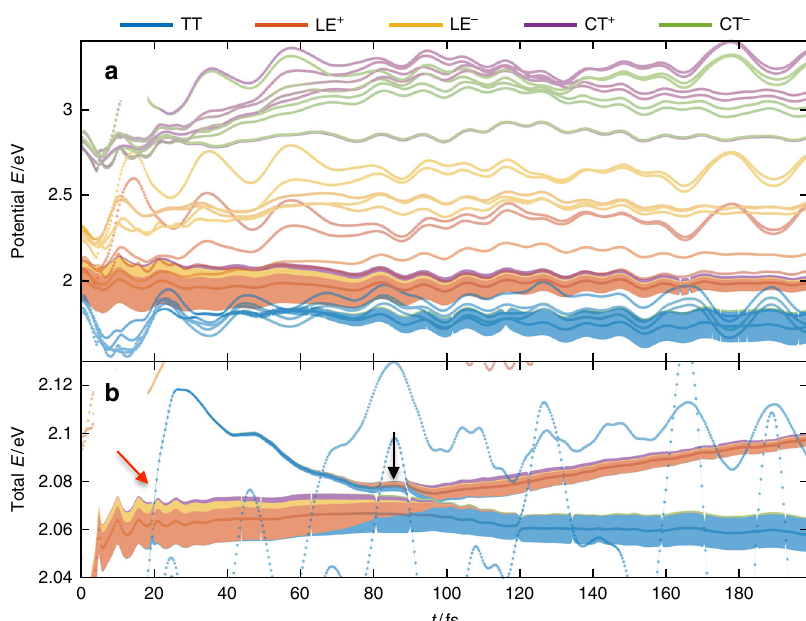
Fig. 6 Energy surfaces and their electronic populations. Each bath state ϕ i ( i = 1 – 5) creates its own set of fi ve energy surfaces, computed as the eigenstates of V eff ( t ) (PES) shown in ( a ) or H eff ( t ) (TES) shown in ( b ). The fi lled areas indicate the amount of the electronic population on each surface. The surfaces are coloured according to their amplitudes of each diabatic electronic states they contain. The red and black arrows on the TES indicate important events that lead to fi ssion by an adiabatic avoided crossing, as decribed in the